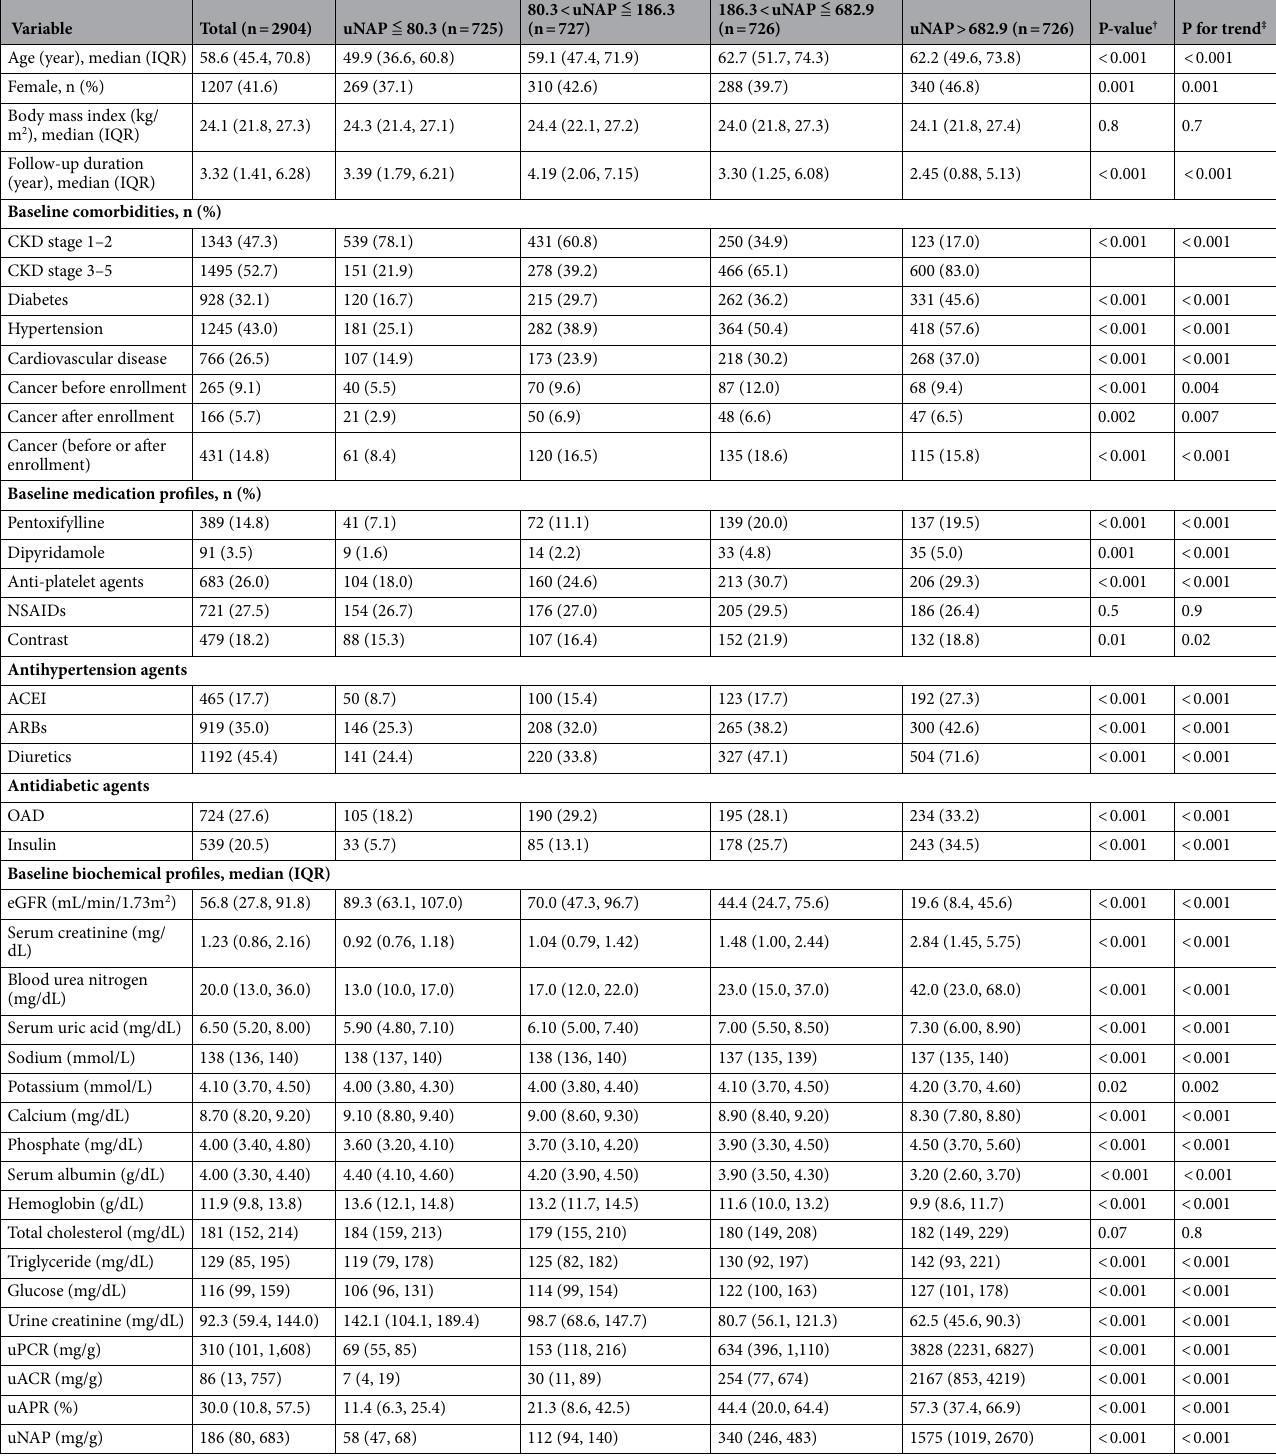
Table 3. Baseline demographic and clinical characteristics stratified by quartiles of urine non-albumin proteinuria (uNAP) defined by subtracting uACR from uPCR ratio. ACEI angiotensin-converting-enzyme inhibitors, ARBs angiotensin receptor blockers, CKD chronic kidney disease, eGFR estimated glomerular filtration rate, NSAIDs nonsteroidal anti-inflammatory drugs, OAD oral antidiabetic agents, uPCR urine protein-to-creatinine ratio, uACR urine albumin-to-creatinine ratio, uAPR urine albumin-to-protein ratio, uNAP urine non-albumin proteinuria. † P-values are calculated by Kruskal–Wallis test for continuous variables and Chi-square test for categorical variables. ‡ P-values for trend are calculated by Spearman’s correlation for continuous variables and by Cochran-Armitage trend test for binary